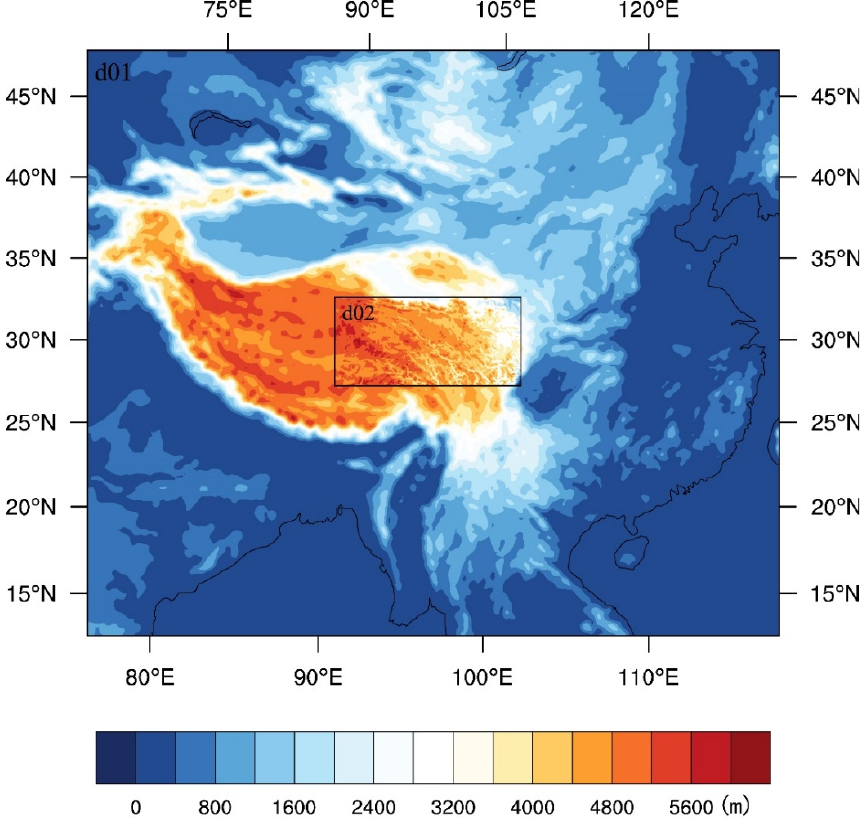
Figure 2. The terrain elevation map of the WRF nested domains. WRF-Hydro has the same settings as WRF, except the inner domain (d02) is coupled with a routing subgrid in